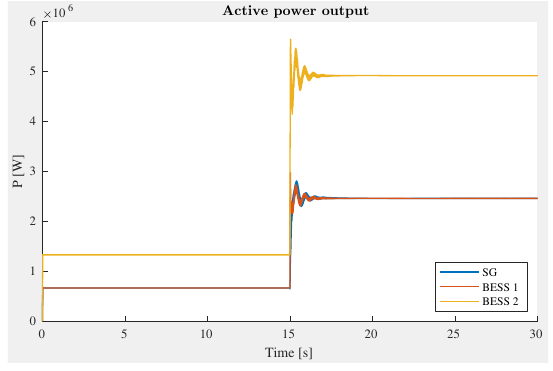
Figure 12. Active power output.